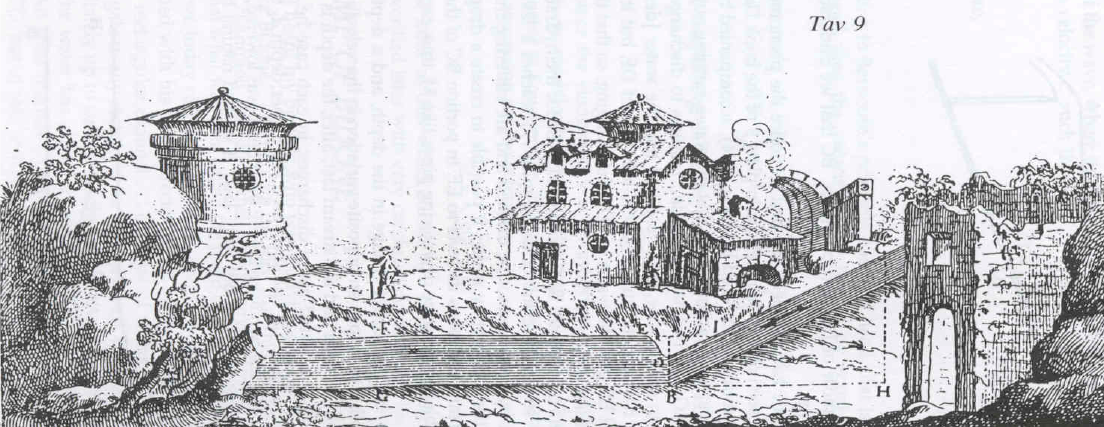
Figure 3. Hydraulic jump (by Guglielmini [2]).